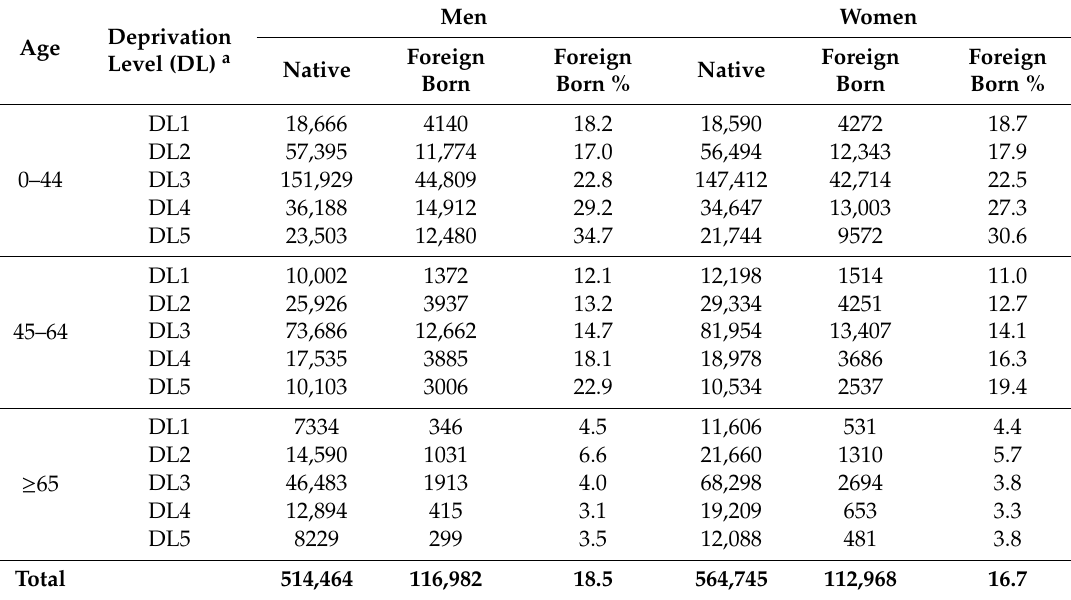
Table 1. Average annual population for the three cities by age group, sex and level of deprivation according to census tracts and country of birth between the years 2009 to